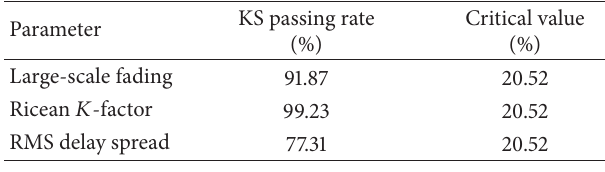
Table 2: KS test passing rate of the Gaussian distribution.